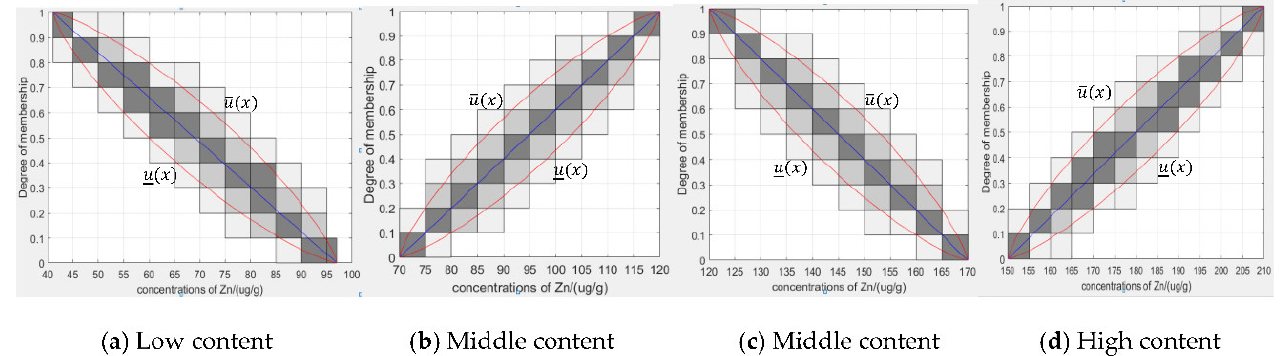
Figure 5. The granular type-2 fuzzy membership function for zinc.